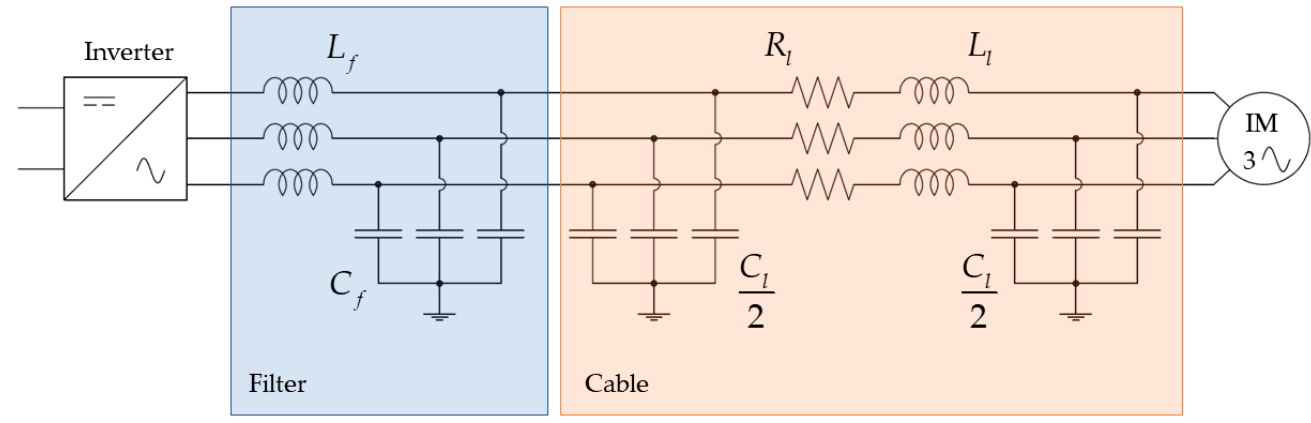
Figure 4. Eigenvalues plot varying motor speed.